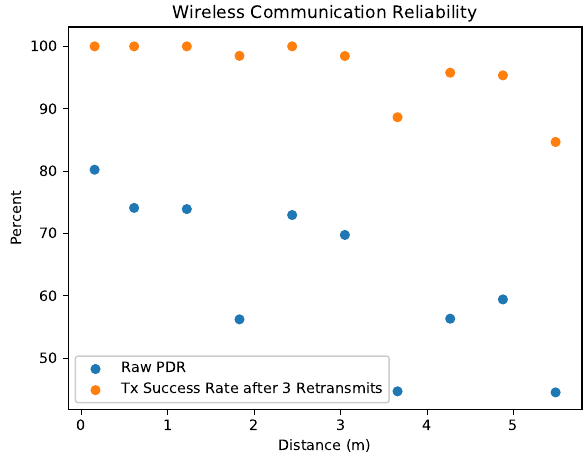
Figure 8. Reliability of robot to anchor beacon broadcasts within OpenWSN. Each broadcast from robot to anchor consisted of three redundant retransmissions of the broadcast’s packet. Packet delivery rate (PDR) was calculated as the ratio of all packets (including redundant retransmissions) that are successfully received by the anchor, which is also approximately the success rate of a broadcast not using redundant transmissions. Transmission success rate was the percent of broadcasts where at least one of the three retransmitted packets were received. RF interference within the experiment space decreased the packet, which is evident in the low PDRs at short distances. Retransmitting packets three times improved the success rate of the